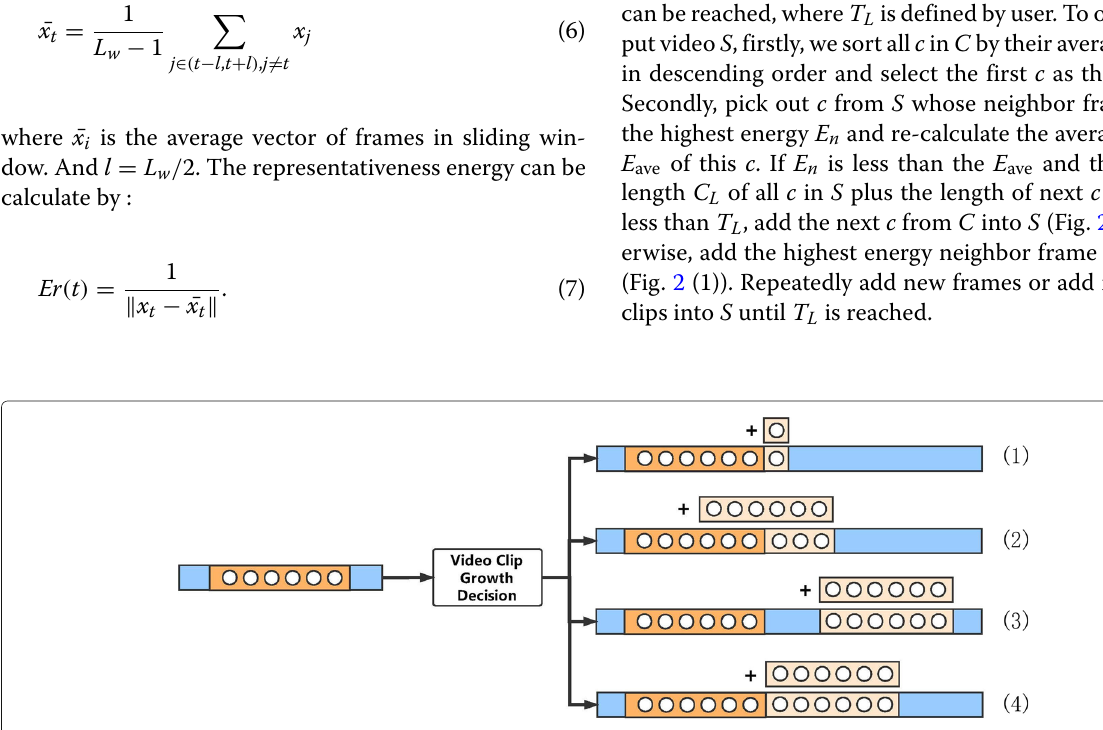
Fig. 2 Video clip growing vitalization and merging cases. From top to bottom: 1 Adding a new frame to the selected video clips. 2 Adding a new clip to the selected clips with overlap, we just preserve the new non-overlapping frames. 3 Adding a new clip without overlap. 4 Adding a new clip which is adjacent with one previous. We merge this two video clips into